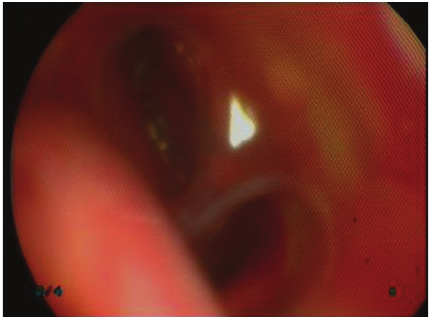
Figure 2: The orifice of the upper left lobe appears to be obstructed by submucosal infiltration bronchoscopically. Following Y stent insertion, the inlet of this lobe is observed to be occluded with the sealed leg and the lower lobe is observed to be clear and